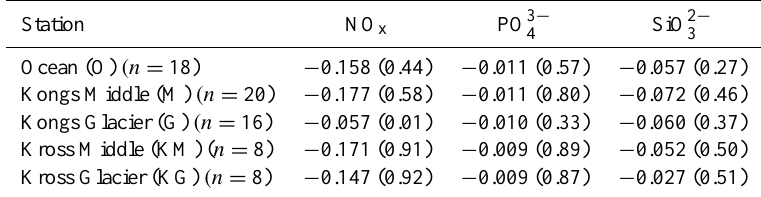
Table 1. Early spring nutrient removal rates. Station NO